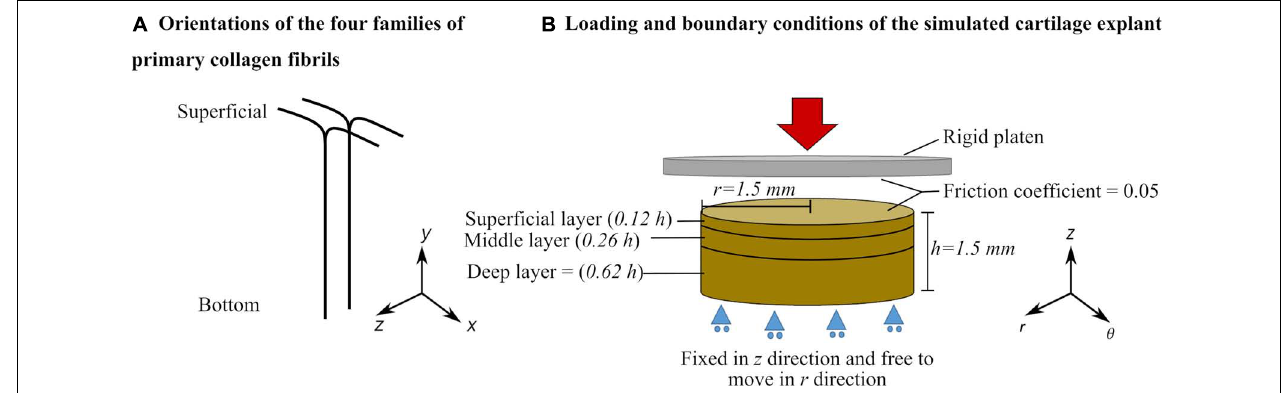
FIGURE 1 | (A) Primary collagen fibril orientation and (B) Geometry, loading, boundary conditions and layers of the cartilage explant defined in the finite element model (see Supplementary Material for details about cartilage layers and depth-dependent properties).